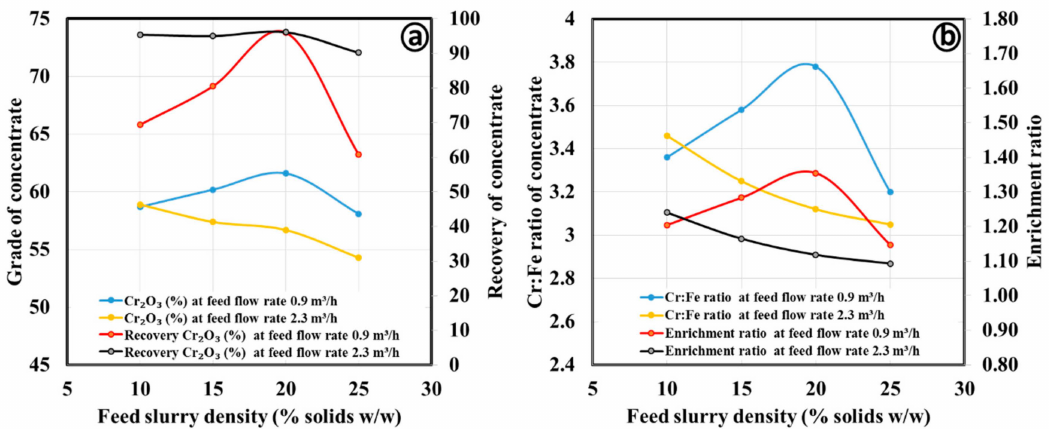
Figure 8. Influence of the feed flow rate and slurry density on the treatment of fine concentrate by the spiral FM1 design ( a ) for grade and recovery; ( b ) for Cr:Fe ratio and enrichment ratio of concentrate.